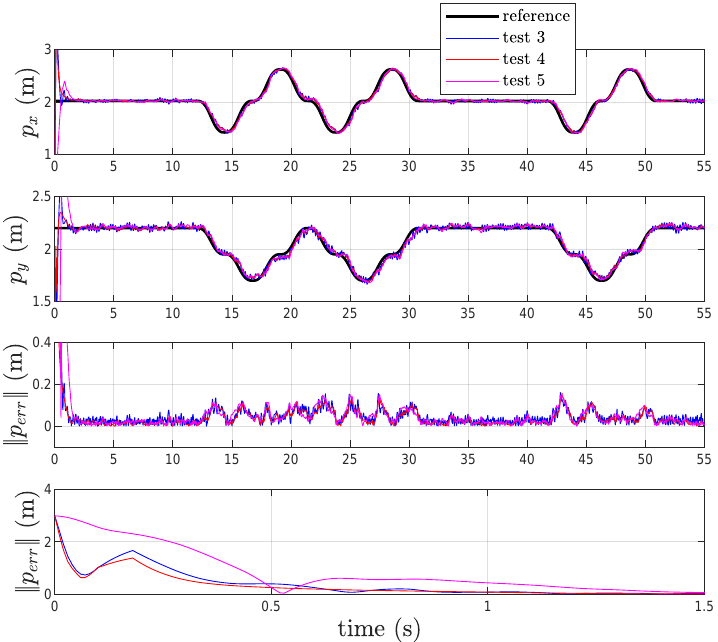
Figure 9. References, estimated coordinates of P , and corresponding norm-2 error (cid:107) P err (cid:107) in Test 3, 4 and Test 5 .